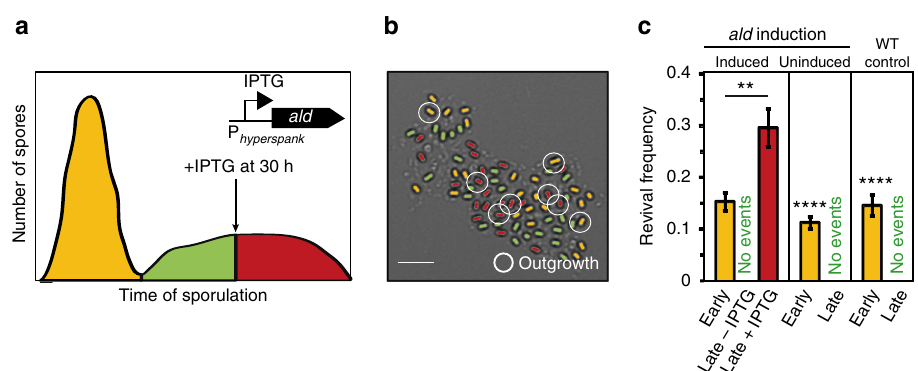
Fig. 9 Alanine dehydrogenase contributes to a spore ’ s intrinsic memory. a Schematics illustrating the formation of three different spore subpopulations by inducing Ald in the progenitor cells of spores formed after 30 h from an IPTG-inducible promoter. Scale bar: 5 µ m. b Effect of Ald expression in progenitor cells on spore revival to L -alanine. Scale bar: 5 µ m. c Corresponding revival frequencies. Strain: BIB1300, Data: mean ± SEM, n c ≥ 13 ( n s ≥ 1000), unpaired